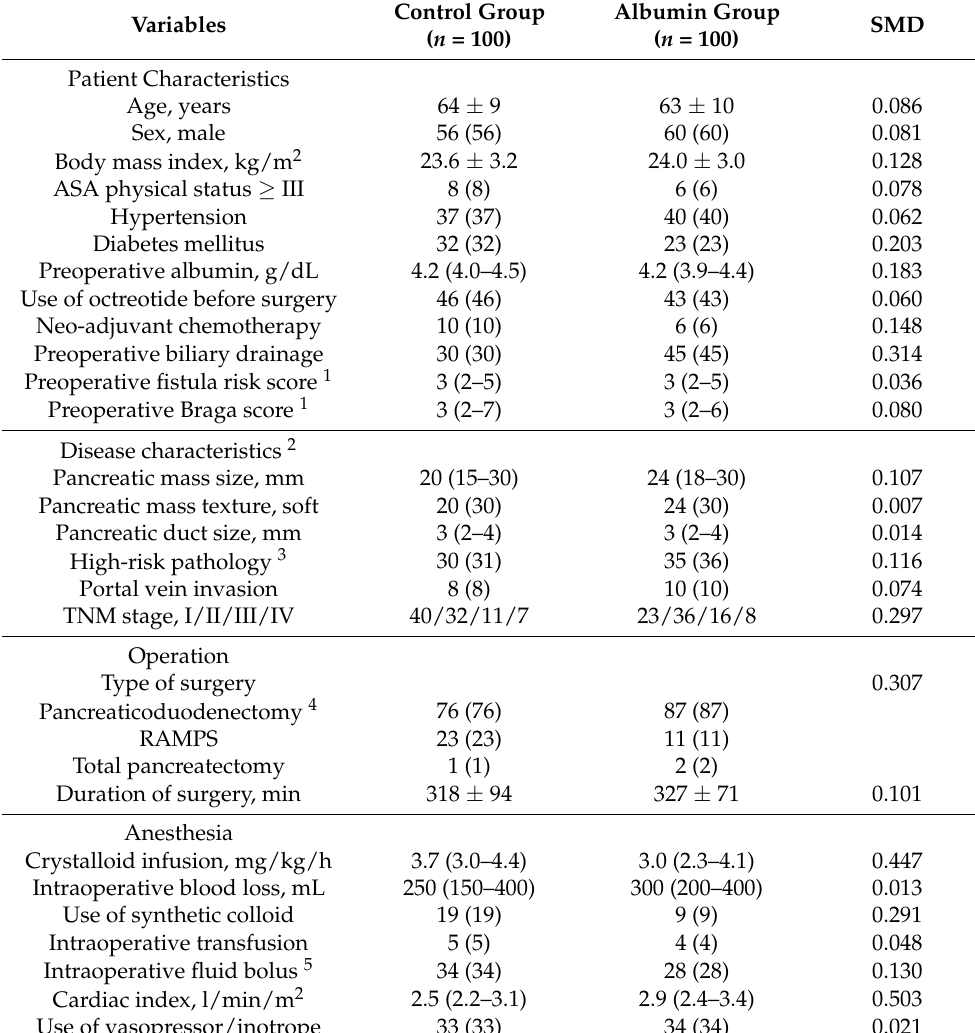
Table 1. Baseline characteristics of patient, operation, and